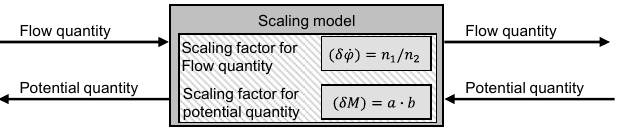
Figure 9. Scaling factors to compensate for size level.